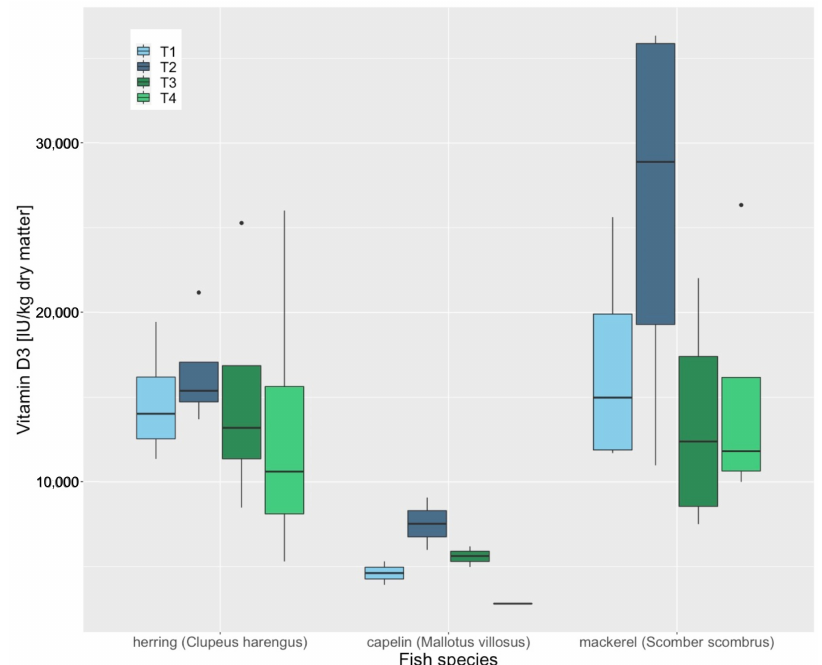
Figure 2. Vitamin D3 concentrations of whole frozen herring (Clupeus harengus), mackerel (Scomber scombrus) and capelin (Mallotus villosus), thawed in the refrigerator (4 ◦ C for 24 h), measured at 4 different time points. T1, day of delivery, T2, 60 days after, T3, 120 days after, T4, 180 days after delivery. “ • ” are